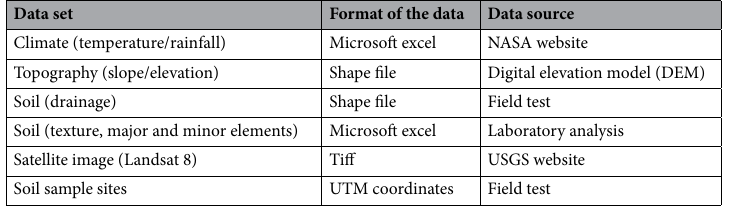
Table 2. Datasets for the study.